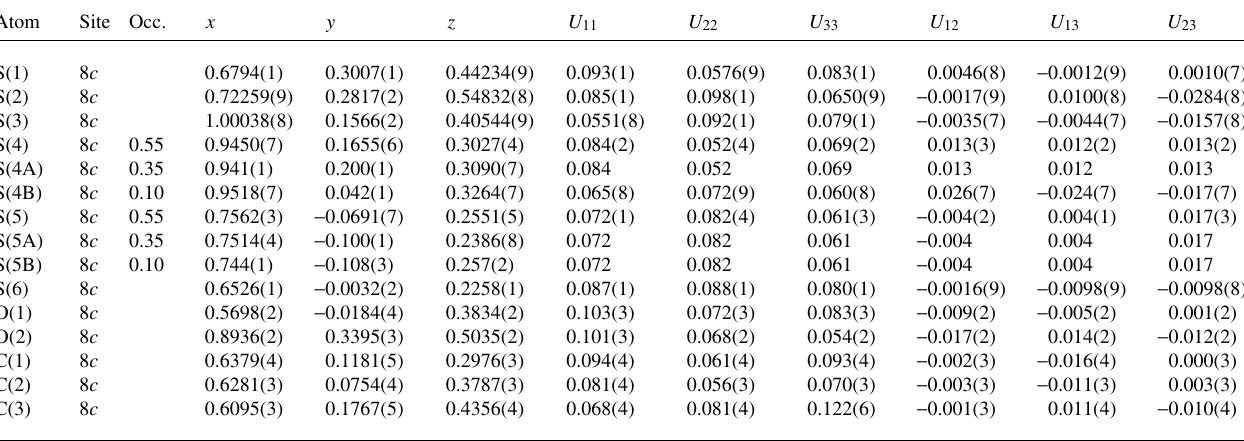
Table 3. Atomic coordinates and displacement parameters (in Å 2 )